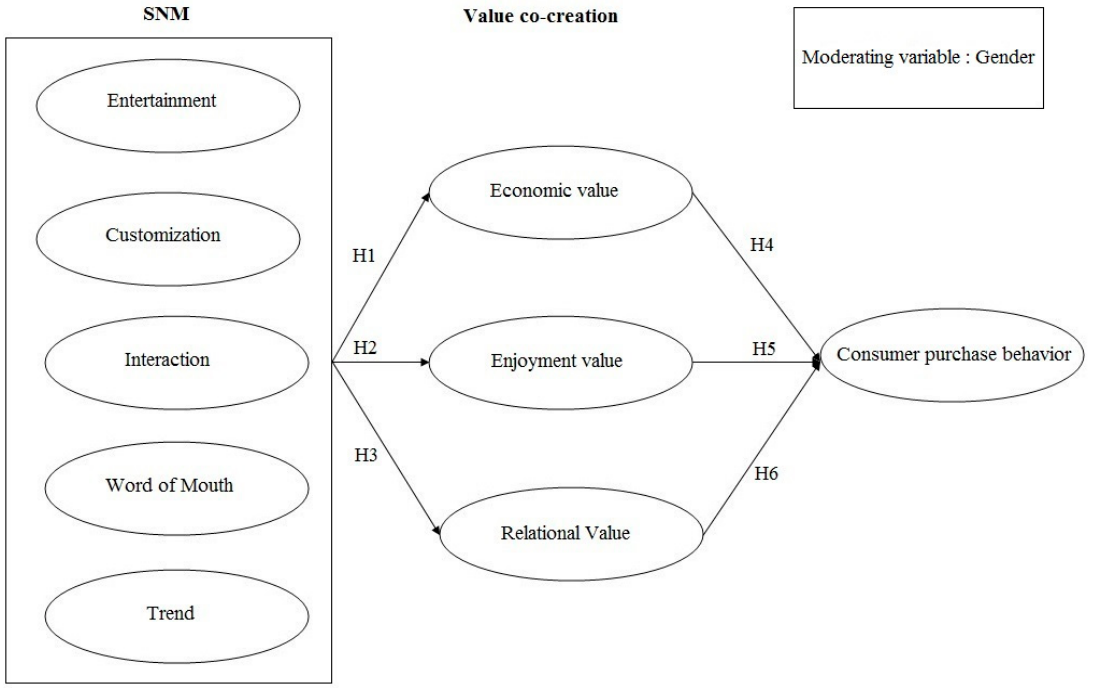
Figure 1. Research framework (source: authors’ elaboration).